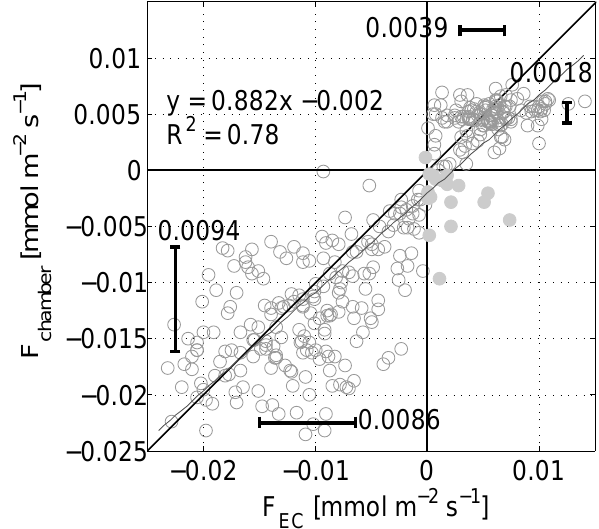
Fig. 1. Scatterplot of EC- and chamber-determined NEE: light grey filled circles represent CO 2 fluxes with opposite directions, and black bars show interquartile ranges of EC/chamber CO 2 source and sink fluxes, respectively (opposite CO 2 fluxes